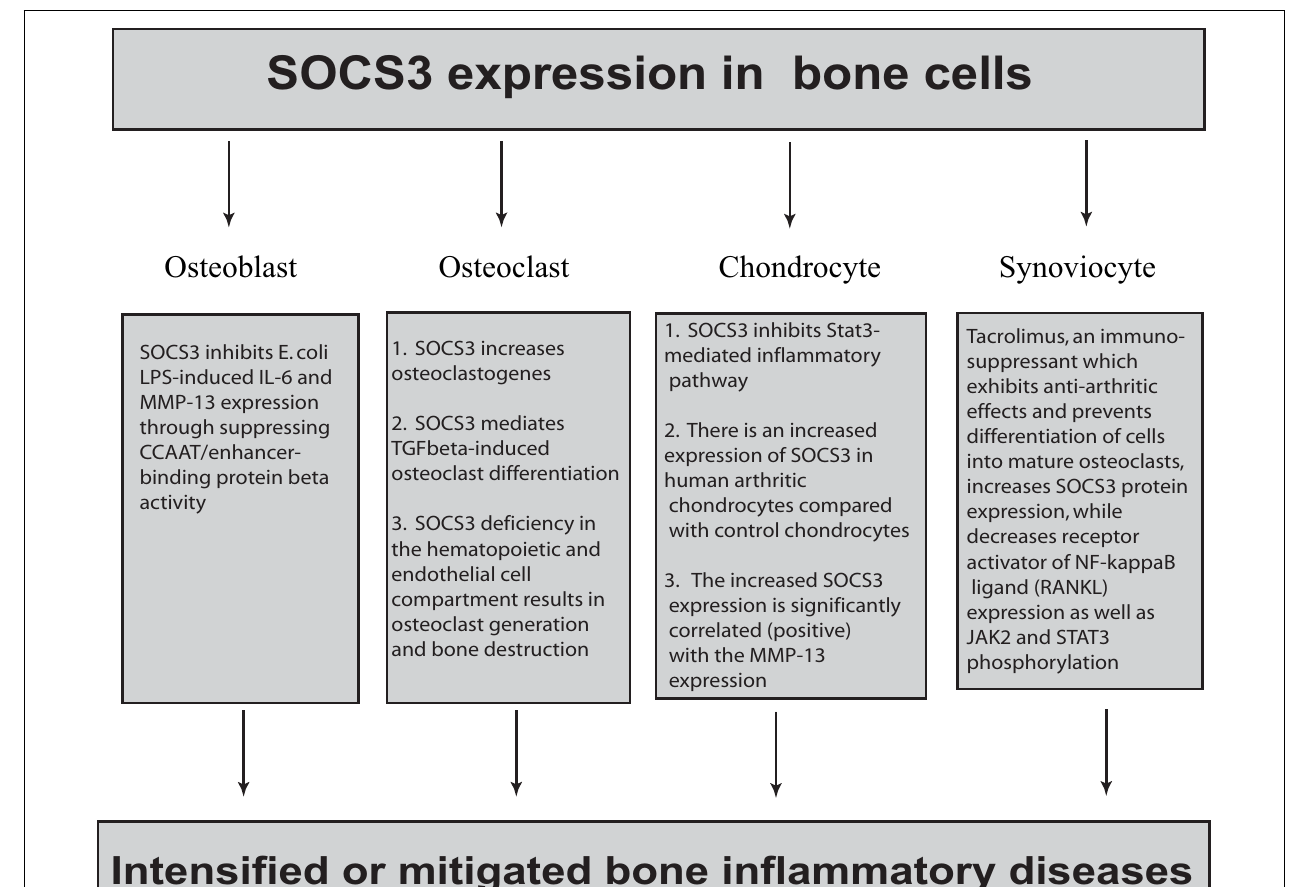
increased expression of SOCS3 in human arthritic chondrocytes compared with control chondrocytes.There is a strong positive correlation between SOCS3 expression and MMP-13 suppression.Tacrolimus, an immunosuppressant, was shown to exhibit anti-arthritic effects by regulating inflammatory cytokine production in RA. Additionally, tacrolimus prevents differentiation of cells into mature osteoclasts, thereby conferring protection against bone resorption. In fibroblast-like synoviocytes, tacrolimus increases SOCS3 protein expression while it decreases receptor activator of NF- κ B ligand (RANKL) expression as well as JAK2 and STAT3